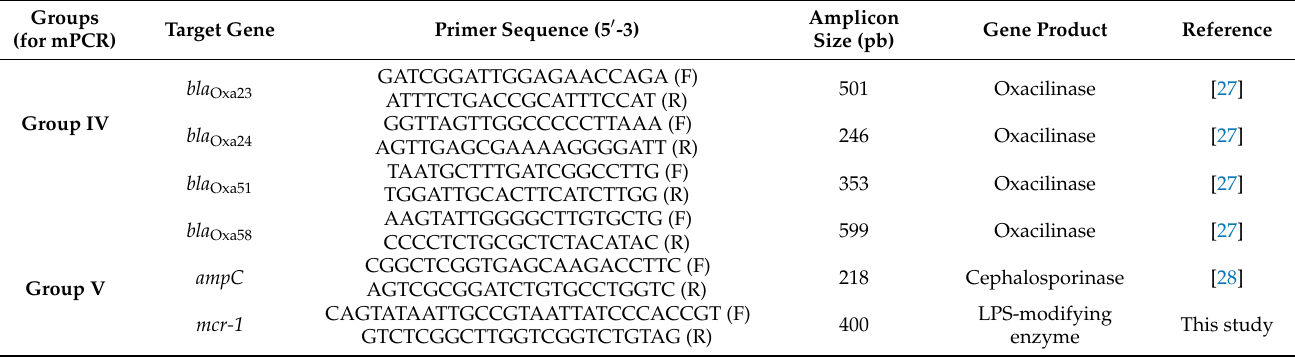
Table 2. Primers for the detection of different resistance genes in Pseudomonas aeruginosa isolates evaluated in this study. Groups (for